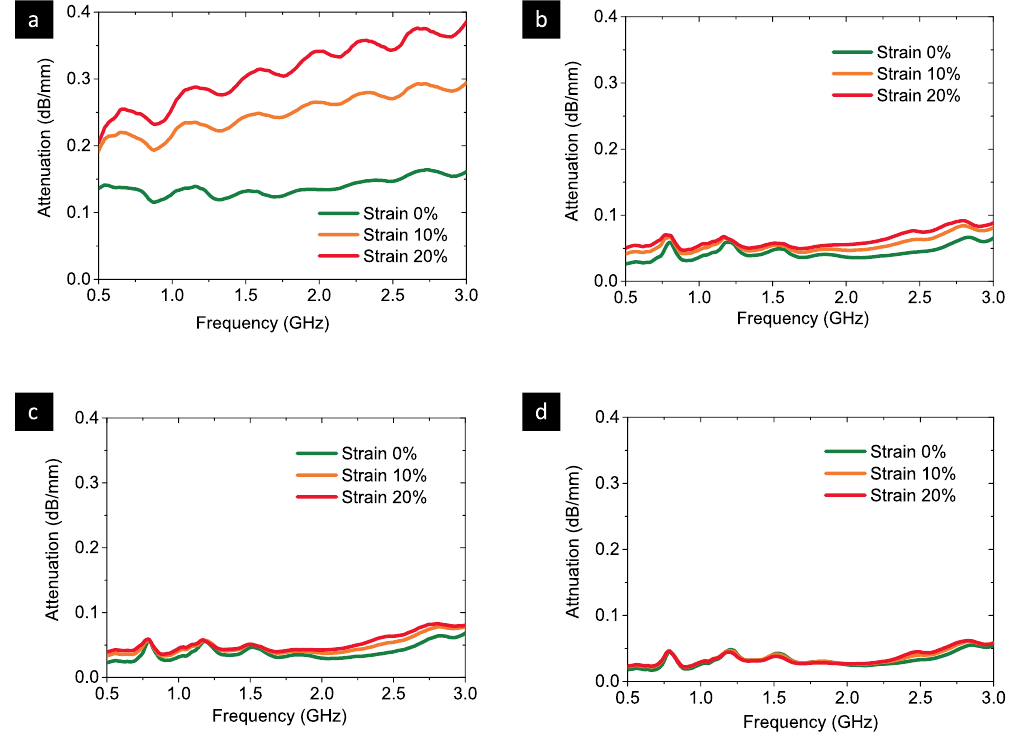
Figure 4. Performance of the transmission line with various stretching. The stretching attenuation in ( a ) 18 v%, ( b ) 20 v%, ( c ) 22 v% and ( d ) 24 v% Ag-PDMS transmission